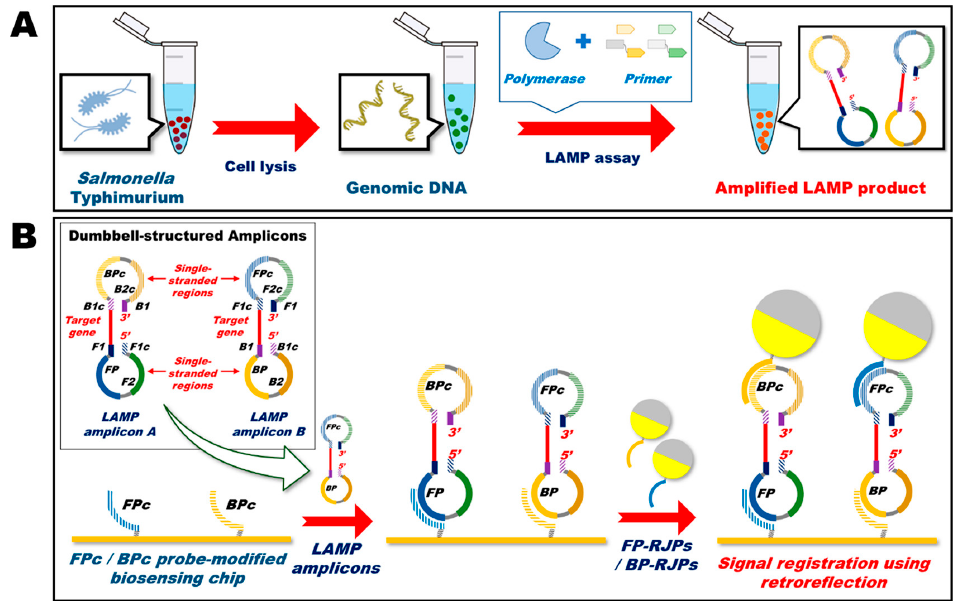
Figure 13. Schematics of optical biosensing platform based on the LAMP assay. ( A ) Synthesis of amplified LAMP product and ( B ) Preparation of non-spectroscopic signaling probe. Reproduced with permission from Chun et al. (2018), ©American Chemical Society, 2018.